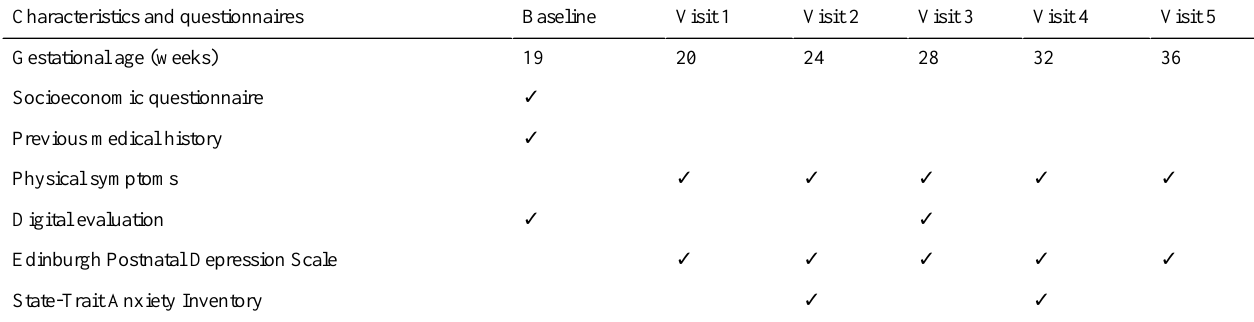
Table 1. Structure of the prenatal